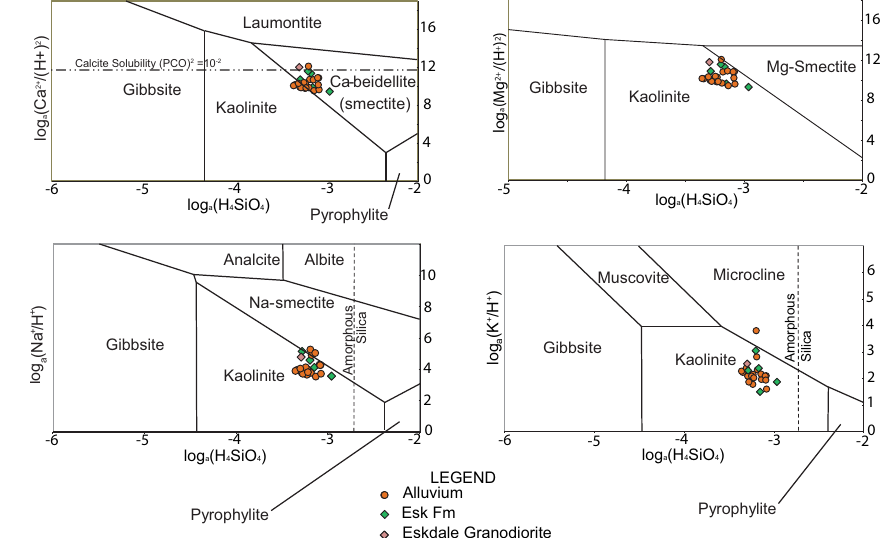
Figure 7. Groundwater silicate stability diagrams based on groundwater samples collected from the study site in 2011 for the (a) CaO– Al 2 O 3 –SiO 2 –H 2 O system; (b) MgO–Al 2 O 3 –SiO 2 –H 2 O system; (c) Na 2 O–Al 2 O 3 –SiO 2 –H 2 O system, including albite; and (d) K 2 O– Al 2 O 3 –SiO 2 –H 2 O system, including